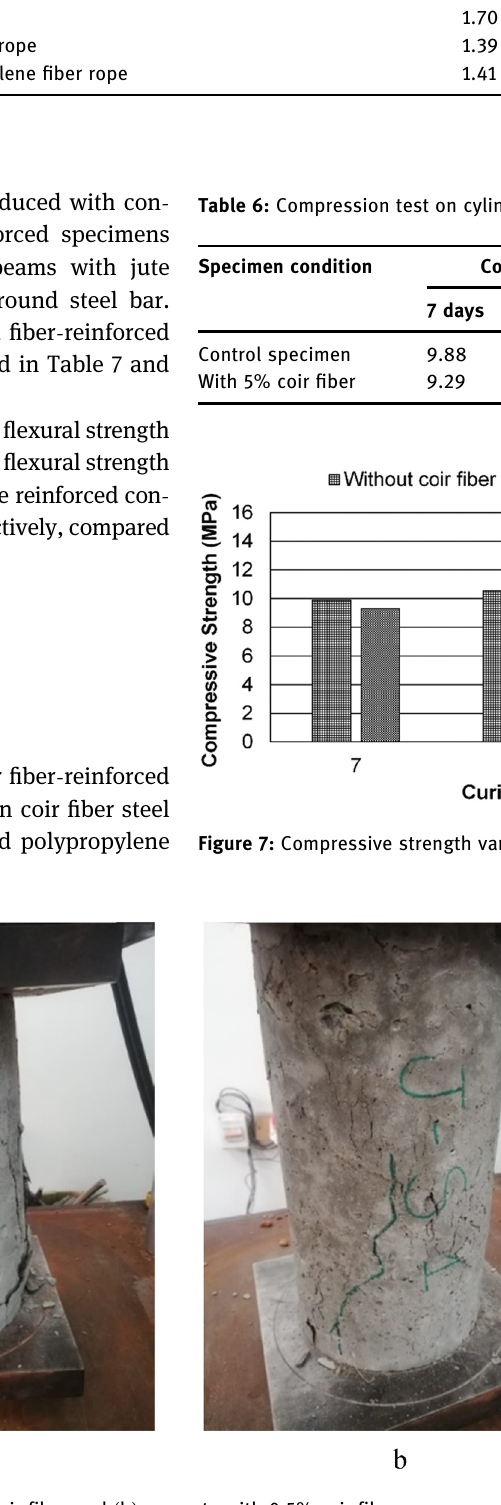
Figure 6: Failure pattern: ( a ) concrete without coir fi ber and ( b ) concrete with 0.5% coir fi ber.